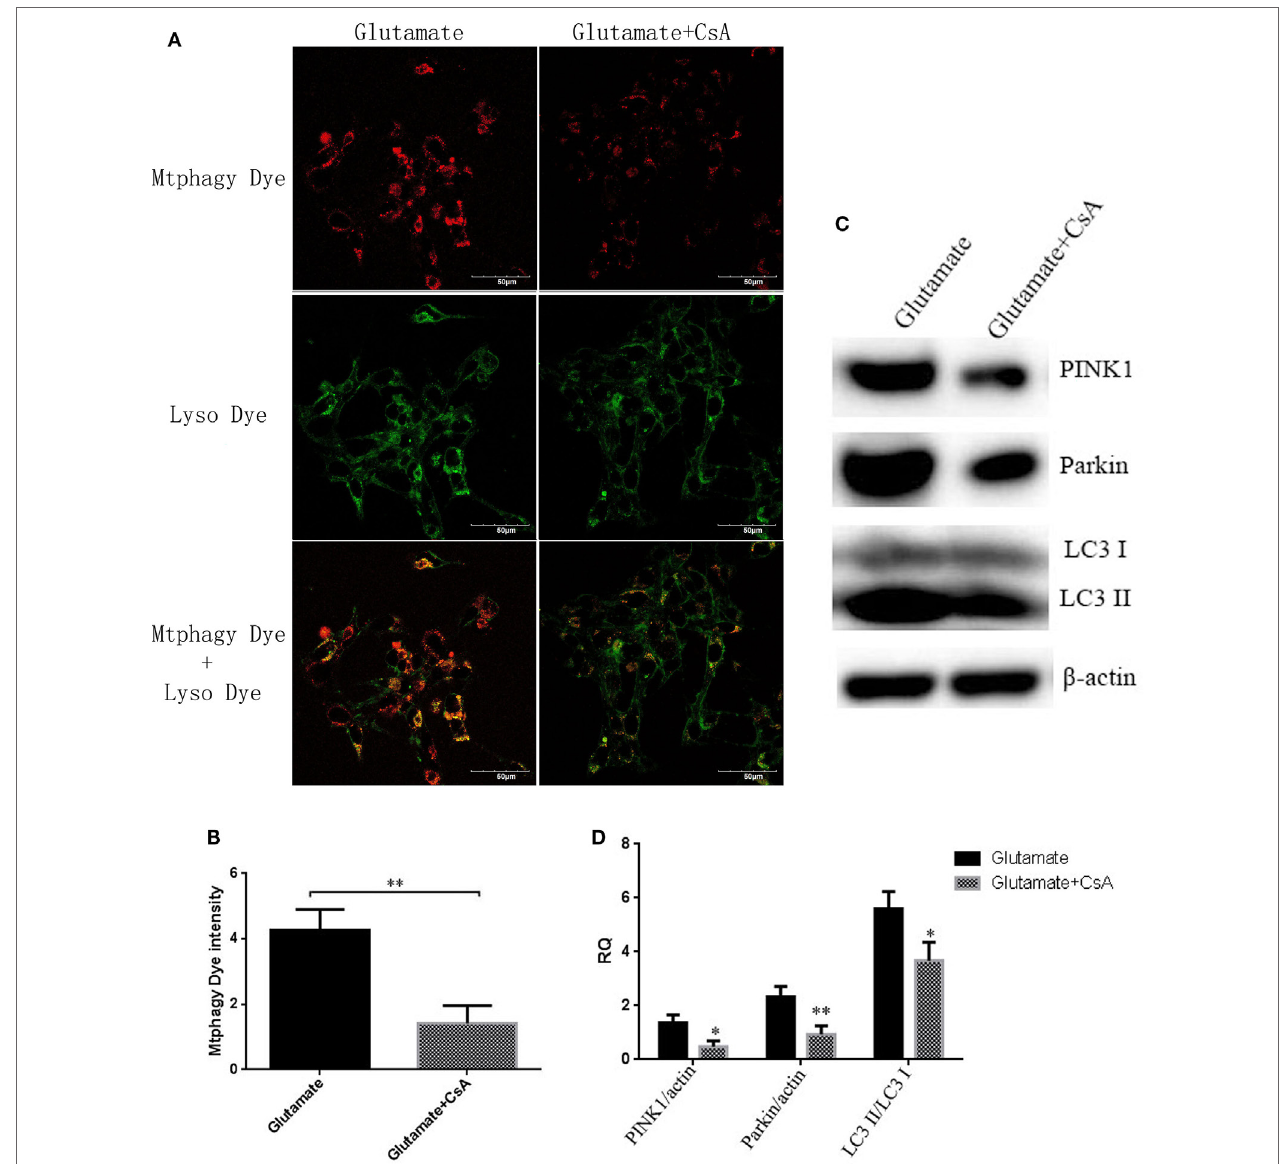
FigUre 8 | The effect of cyclosporinA (CsA) on glutamate-triggered mitochondrial autophagy. (a) The fluorescence intensity of Mtphagy Dye and Lyso Dye in mitochondria of HT22 cells; (B) the quantitative analysis of the average fluorescence intensity of mitochondrial Mtphagy Dye in HT22 cells; (c) Western blot assay of mitochondrial autophagy protein in HT22 cell; (D) the relative expression (integral optical density) of mitochondrial autophagy protein in HT22 cells. * P < 0.05, ** P < 0.01. ns, not